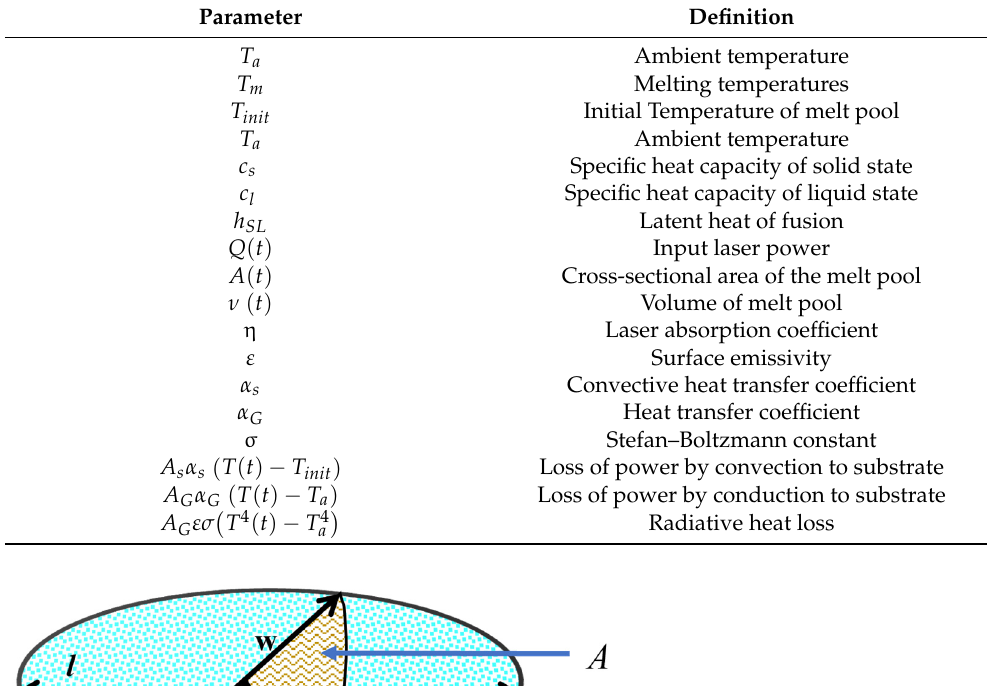
Table 1. Definitions of variables and parameters.